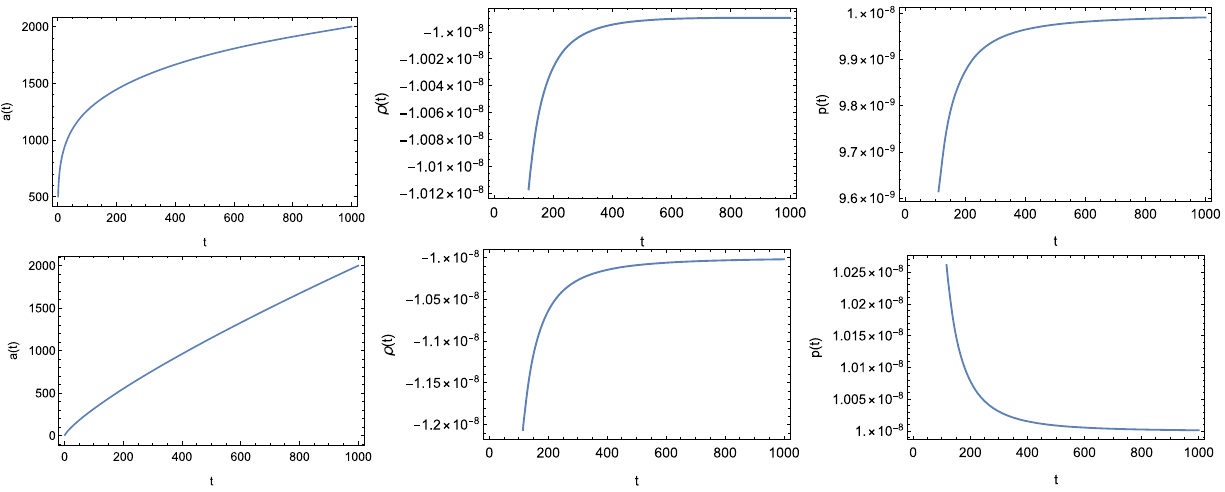
Fig. 4 The evolution of the scale factor a ( t ) , density ρ( t ) and pressure p ( t ) for typical values of q = 0 . 1 in the upper plot and q = 0 . 8 in the lower plot. We have set a s = 2000 , a ES = 0 . 01 , t s = 1000 , λ =